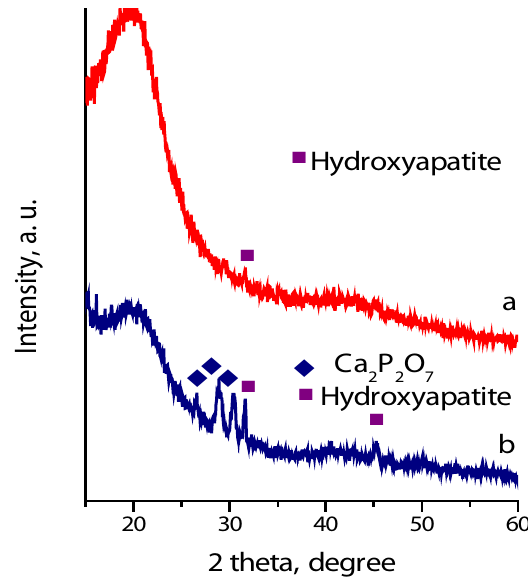
Figure 6. XRD for the PU/10BG (a) and PU/20BG (b) after in vitro test for 7 days.